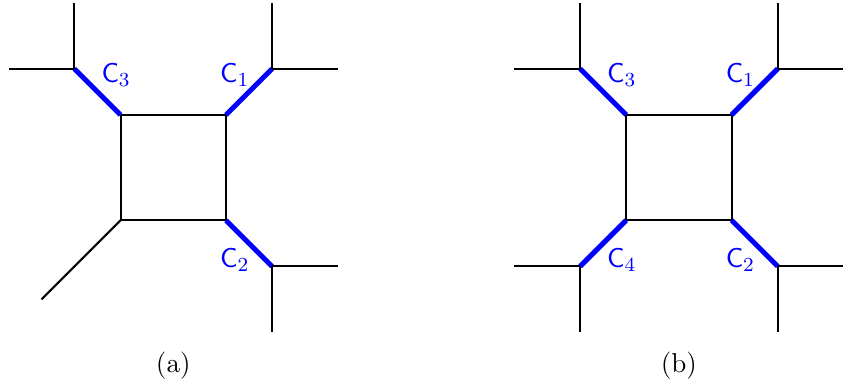
Table 3 . BPS Spectrum of the BPS sector F and d 2 ≤ 8 .